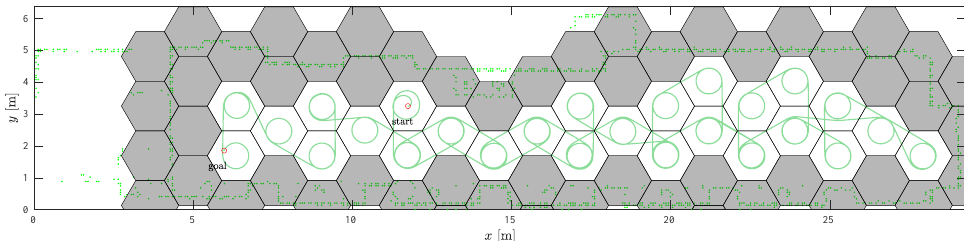
Figure 13. The complete coverage of the HDCP algorithm with hexagonal cell grid.